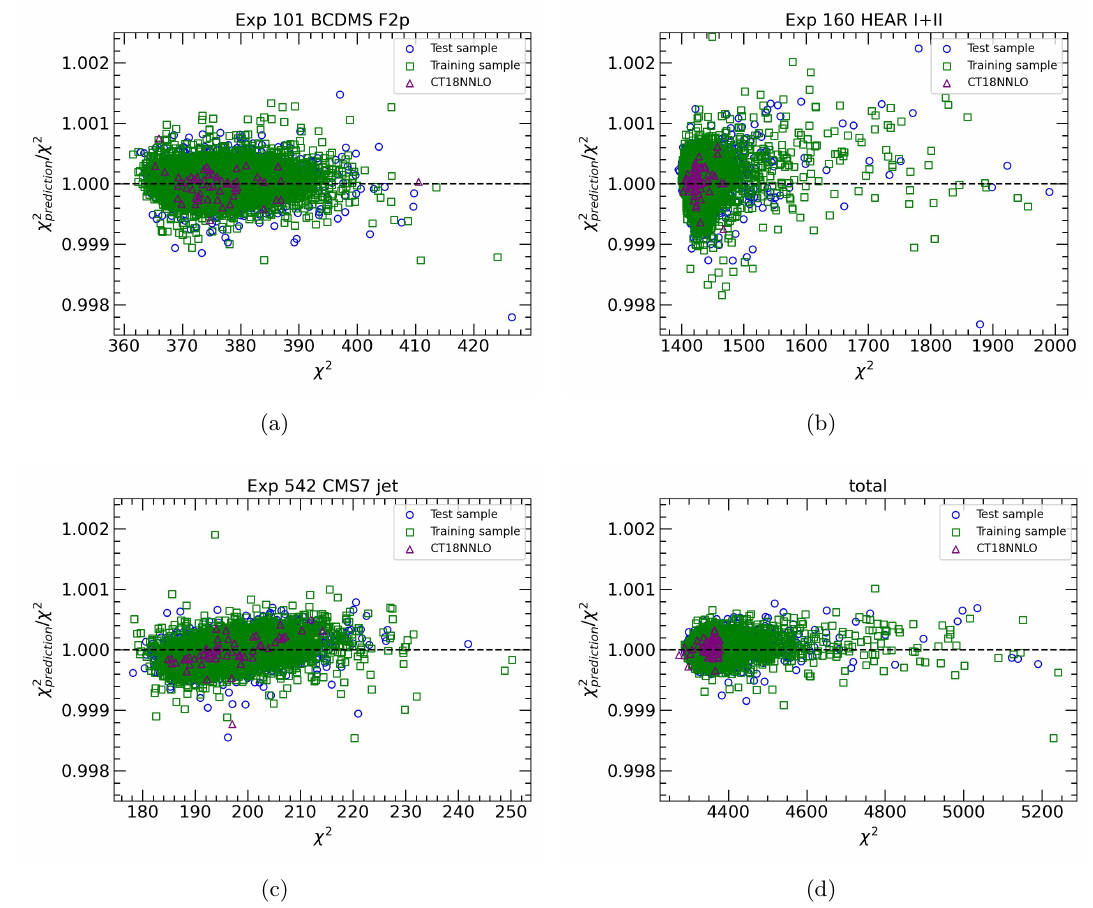
Figure 2 . The predictions to truths ratios of χ 2 for experimental data sets for measurements of the proton structure function by BCDMS, measurements of inclusive DIS reduced cross sections at HERA and measurements of the inclusive jet cross sections at the full data